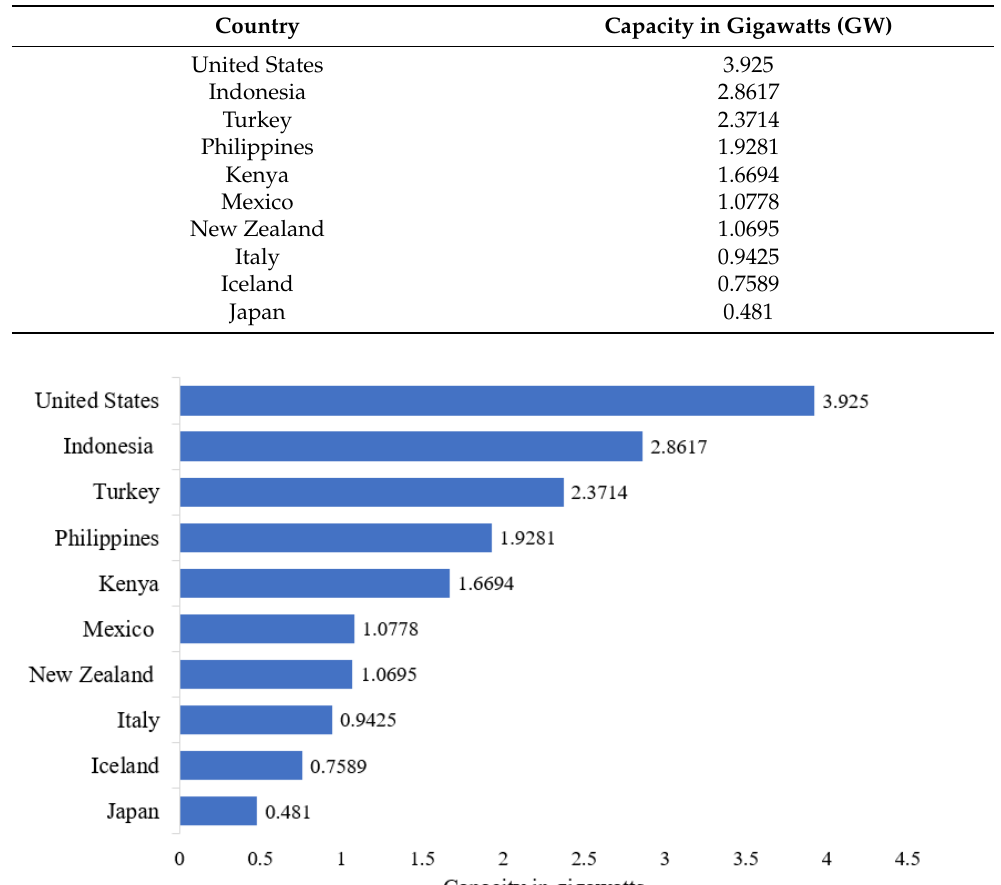
Figure 3. Actual (in-sample) and predicted (out-of-sample) geothermal energy installation capacity values for ( a ) the United States, ( b ) Indonesia, ( c ) Turkey, ( d ) the Philippines, ( e ) New Zealand, ( f ) Mexico, ( g ) Italy, ( h ) Kenya, ( i ) Iceland, and ( j ) Japan. Table 4. Geothermal energy installation capacity prediction for the top 10 countries utilizing geothermal energy in 2030 using the IGM (1,1) model.